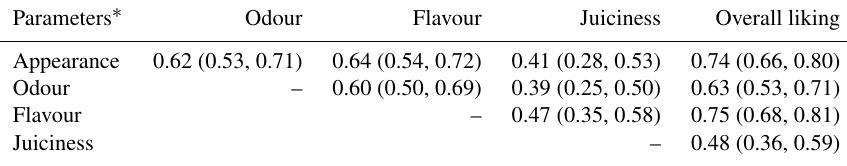
Figure 1. The distribution of genotypes and the sensory characteristics of meat according to the cooking status based on a principal compo- nent analysis. Table 7. Pairwise Pearson correlations (95% confidence intervals for ρ ) between sensory parameters regardless of breed and cooking